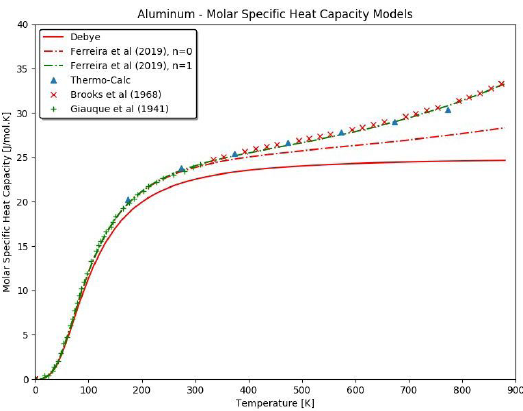
Figure 4. Comparison of the molar heat capacity of pure Zr by carrying out Debye, Thermo-Calc, and Ferreira’s model.